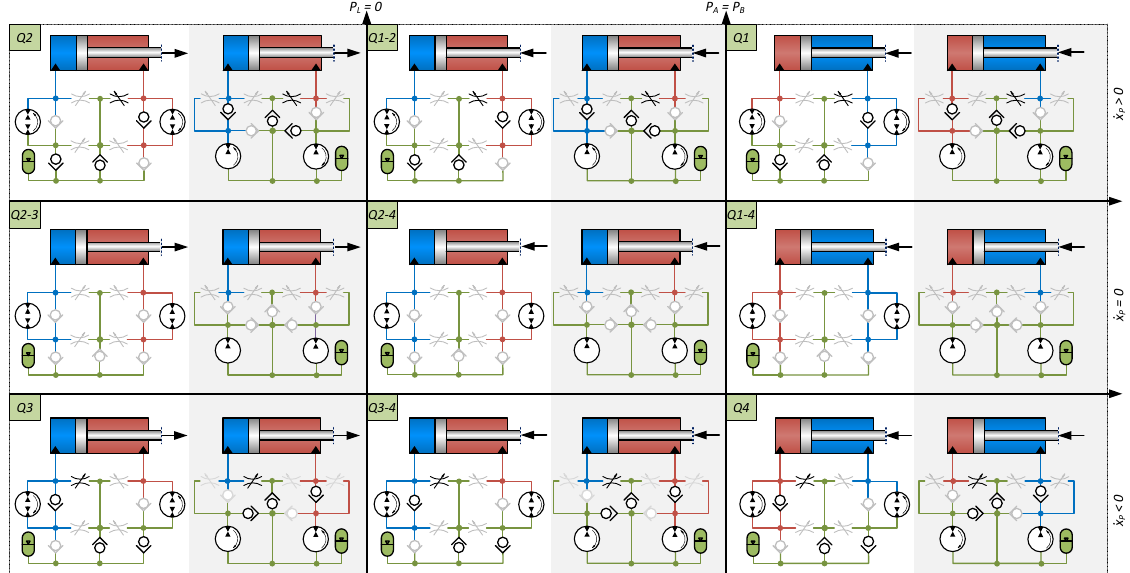
Figure 4. Extended four quadrant diagram(s) for drive architectures in Figure 3, when only actuating valves connecting transmission lines to the reservoir. Schematics in shaded areas are representative for architectures DPDS-R, SPDS-R, DPDS, and SPDS, whereas the schematics in non-shaded areas cover architectures DPCS-R and